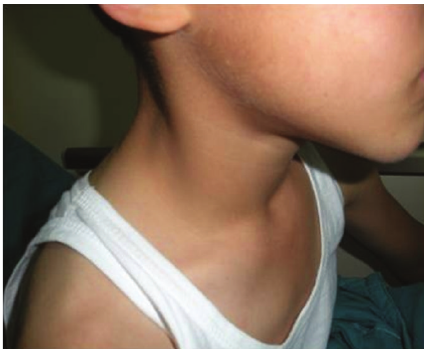
Figure3:Magneticresonanceimagingofthecervicalcystdisclosing its relation to the larynx.